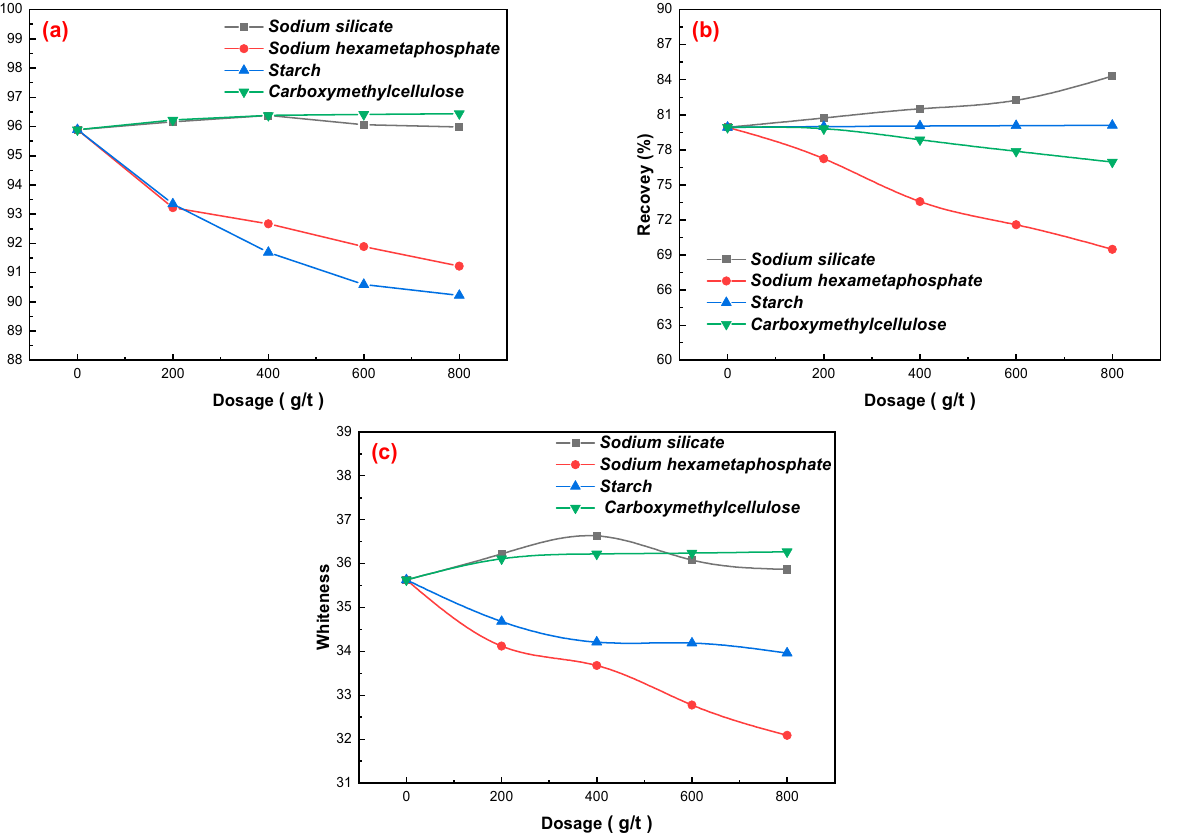
Figure 3. Effects of the dosages of sodium silicate, sodium hexametaphosphate, starch, and carboxymethylcellulose on gypsum purification: ( a ) gypsum purity, ( b ) gypsum recovery, and ( c ) gypsum whiteness.